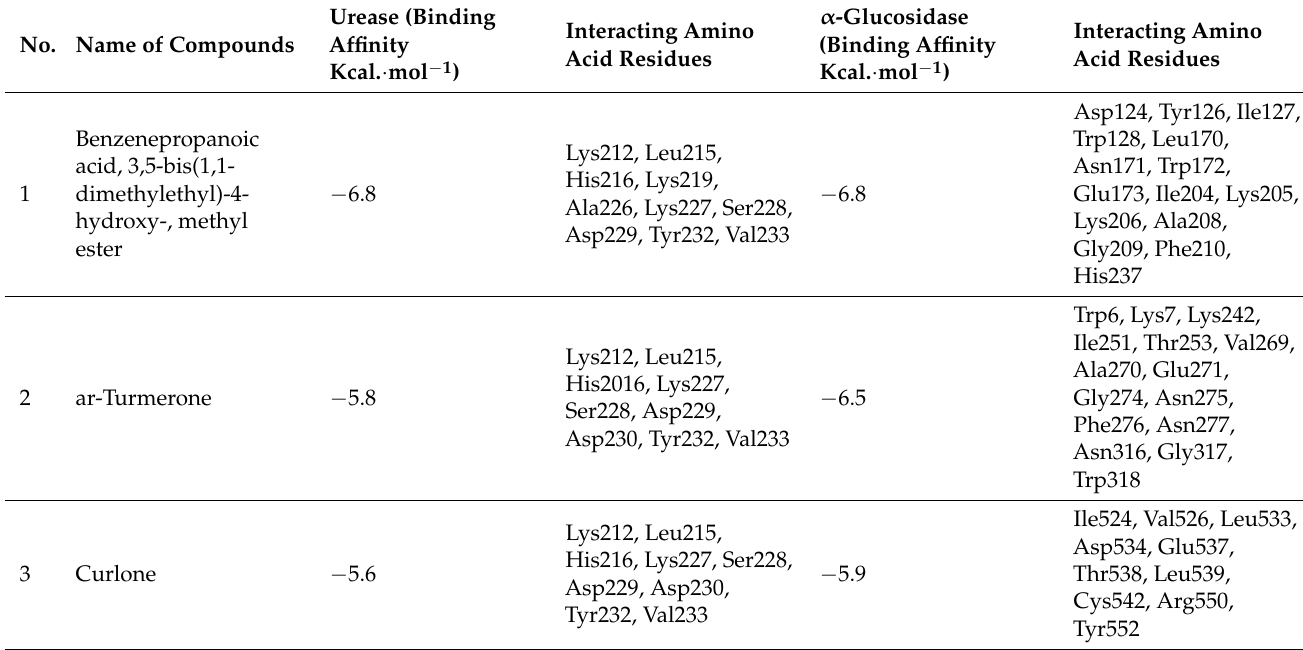
Table 4. Molecular docking of urease and α -glucosidase with different ligands representing binding affinity and interacting amino